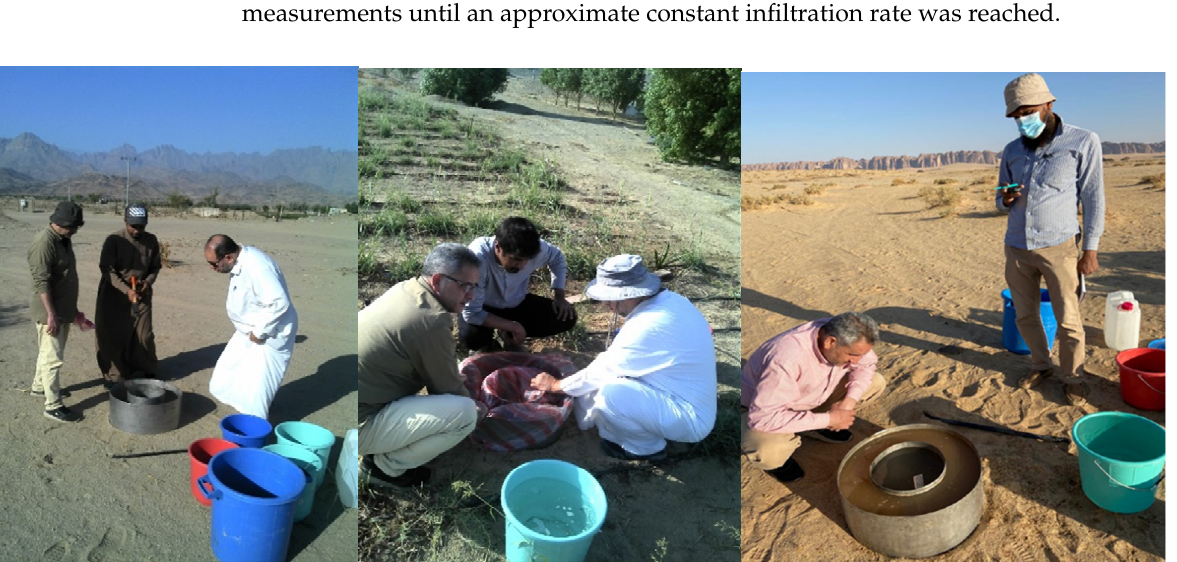
8 of 21 Figure 6. Field ‐ measured infiltration tests: infiltration rates ( a ) and cumulative infiltration depths ( b ) versus time.